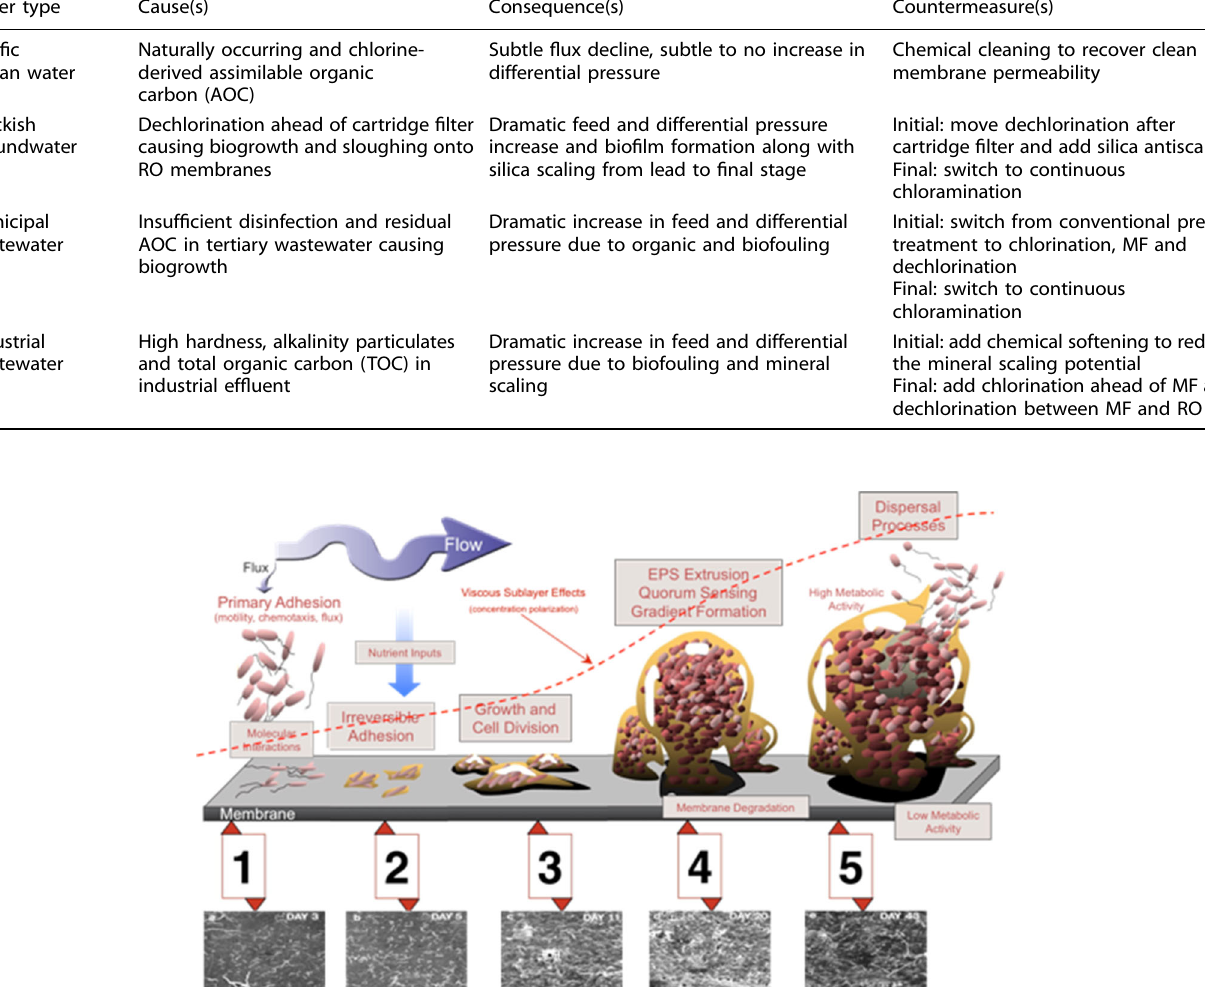
Table 1. Summary of biofouling causes, consequences and countermeasures from case studies. Water type